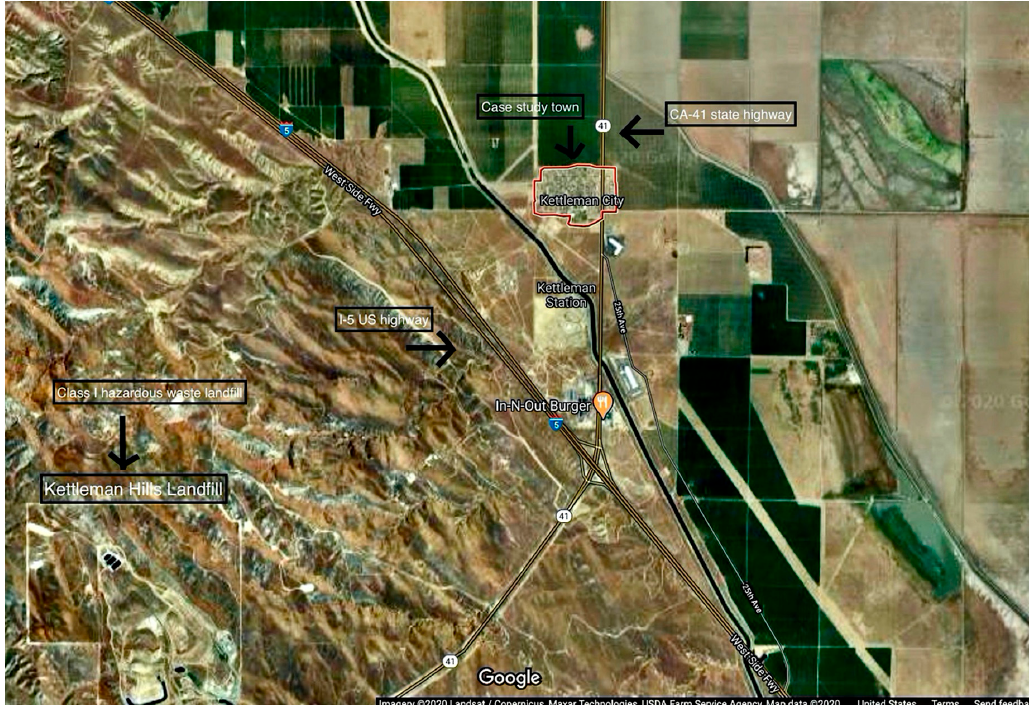
Figure 1. Satellite imagery of Kettleman City showing the community, two intersecting highways surrounded by agricultural land and hazardous waste landfill, Kettleman Hills (imagery from Landsat/Copernicus, Mazar Technologies, U.S. Department of Agriculture Farm Service Agency (2020) accessed via Google Maps at a scale of 2000 feet).